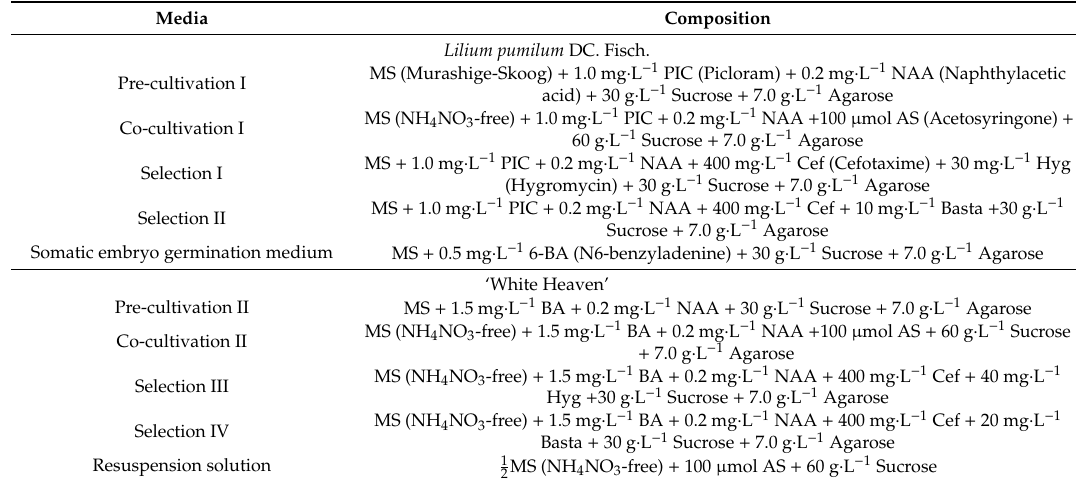
Table A1. Media used for Lilium explant transformation.